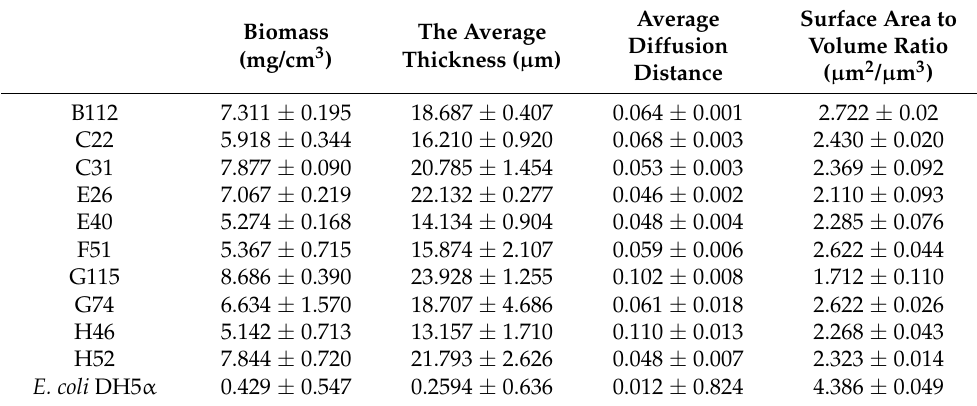
Table 2. Biofilm analysis results of QS bacteria based on COMSTAT analysis